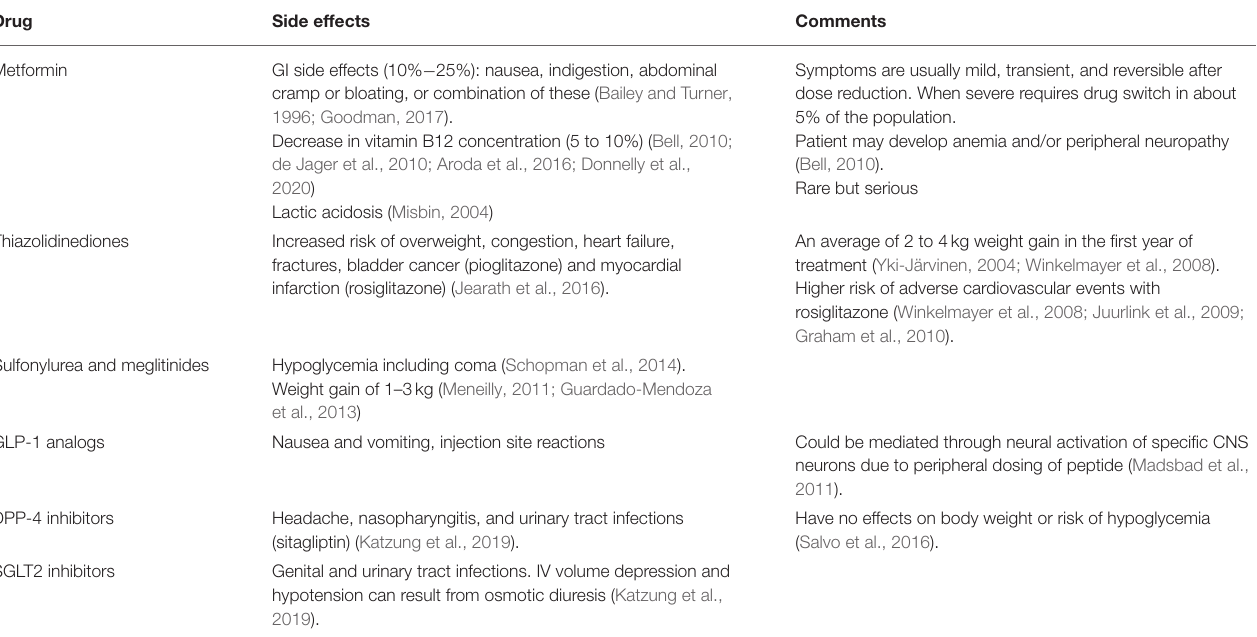
TABLE 1 | List of adverse drug reactions related to glucose-lowering drugs in type 2 diabetes.